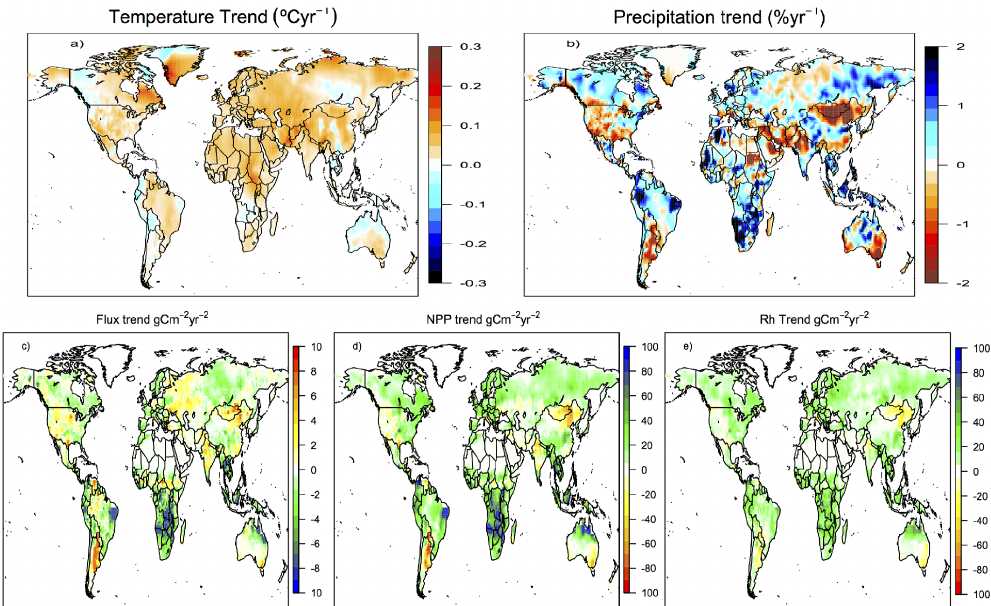
Figure 6. Trends in land climate drivers and process responses. (a) Trend in temperature ( ◦ Cyr − 1 ) , (b) trend in precipitation (% yr − 1 ) , (c) trend in land to atmosphere net CO 2 flux (gCm − 2 yr − 2 ) , (d) trend in NPP (gCm − 2 yr − 2 ) , and (e) trend in RH ( = RH + wildfire + Riverine C flux) (gCm − 2 yr − 2 )